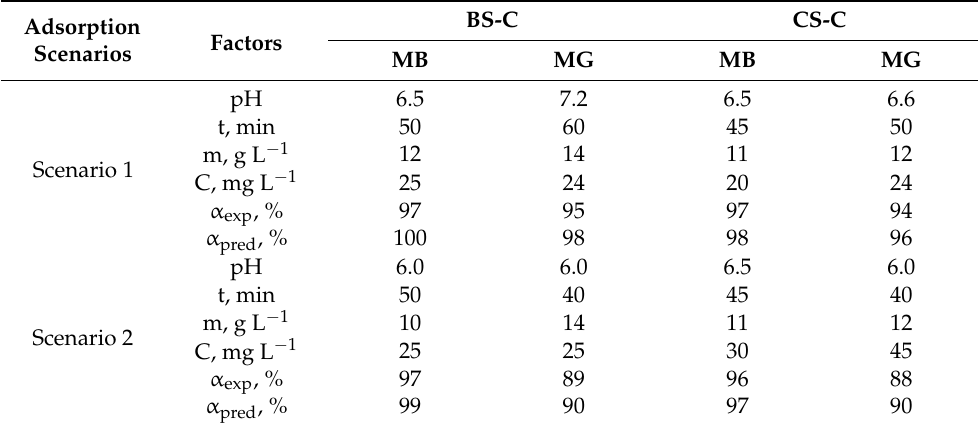
Table 7. Optimum values of the adsorption parameter for maximum removal efficiency of the cationic